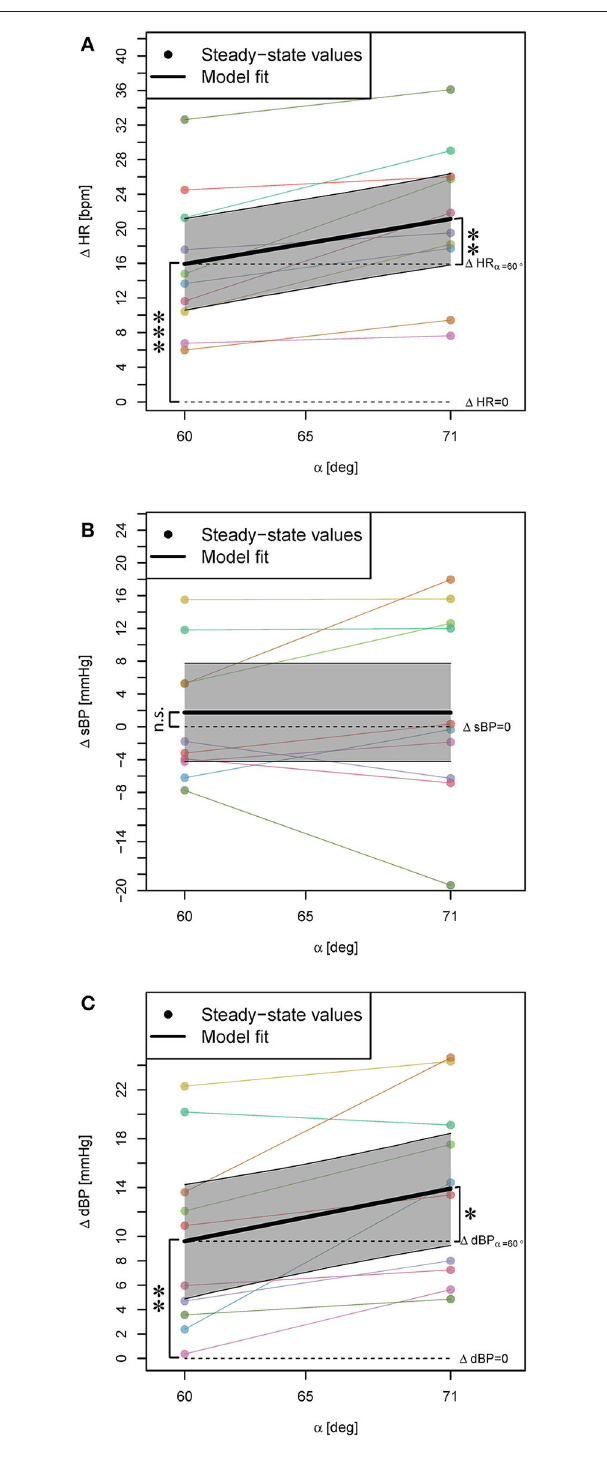
FIGURE 3 | Statistical models for 1 HR, 1 sBP, and 1 dBP responses (changes with respect to supine position) to head-up tilt alone (A–C). The steady-state values for each subject are connected with a line. The highlighted areas show 95% CI. The signs *, **, and *** mark significant findings with p 0.05, 0.01, and 0.001, respectively. n . s . marks ≤ non-significant differences.